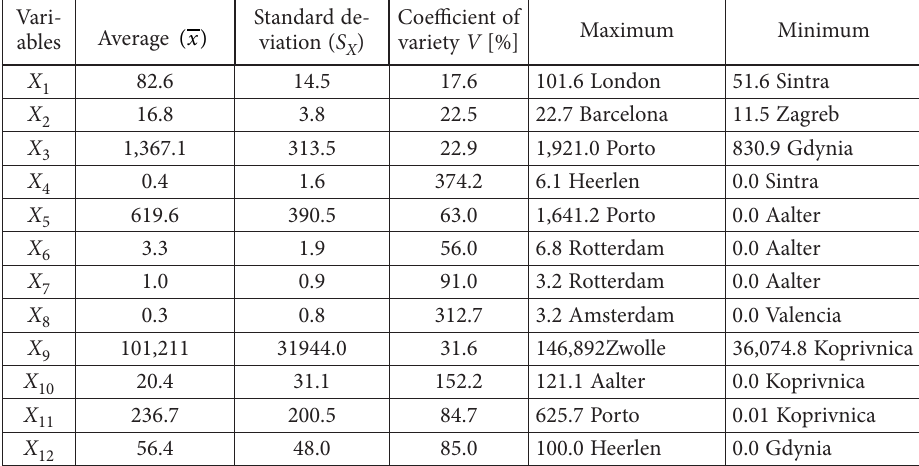
Table 3. Statistical characteristics of diagnostic variables